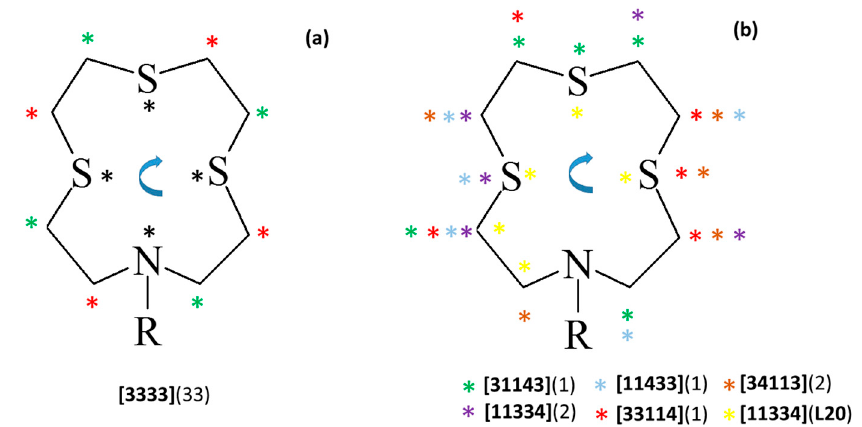
Figure 6. Schematic representation of the conformations adopted by the [12]aneNS 3 ( L ) macrocyclic moiety in the 31 X-ray crystal structures (43 independent units) retrieved from the CSD (Table S5 in the Supplementary Materials) featuring L derivatives (Figure 1) and their metal complexes. Asterisks indicate the corners in the various conformations according to the Dale notation. ( a ) Corner positions observed in [3333] conformations: black asterisks refer to the corner positions observed in free ligands, while red and green asterisks identify the corner positions observed in ligands coordinated to metal centers, and numbers in round brackets represent the overall number of independent units having the [3333] conformation; ( b ) corner positions in the alternative conformations observed in metal complexes of L derivatives, with each type of conformation identi fi ed by a di ff erent color of asterisk. The [84] conformation is not represented. To determine the number of bonds between each pair of corners and thereby assign the Dale notation to each conformation observed, start from the fi rst corner to the left of the N atom as shown in the picture and proceed clockwise. This method was chosen to best illustrate the di ff erences between conformations. The Dale notation is conventionally de fi ned with the low numbers (i.e., the shortest edges) speci fi ed fi rst, disregarding clockwise/anti-clockwise direction and crystallographic symmetries. In this way, all the conformations in Figure 6b would be assigned as [11334].